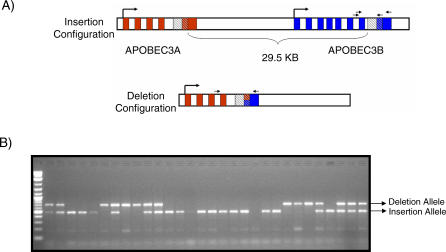
Sequence Structure of Structural Variant and Genotyping Assay Design(A) A fosmid clone containing the deletion variant was completely sequenced and compared to the human reference genome (insertion allele). The deletion removes a 29.5-kb region spanning from the fifth exon of APOBEC3A (shown in red) to the eighth exon of APOBEC3B (shown in blue). The deletion breakpoints map within identical 350-bp blocks (hatched shading) and the deletion is predicted to form a hybrid transcript. PCR assays were designed to distinguish insertion and deletion alleles (short arrows show position of PCR oligonucleotides).(B) PCR breakpoint genotyping assay. Genotyping results for 30 individuals are shown (lane 20 = negative water control lane). All homozygous deletion events were confirmed by a second PCR assay designed to the insertion breakpoint (see Materials and Methods).